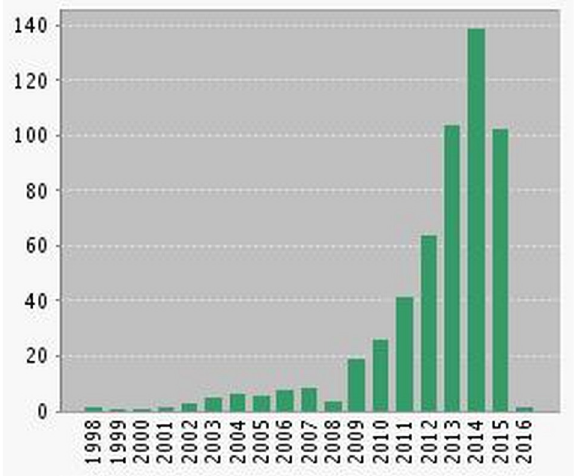
Figure 1: The number of publications on the topic of magnetic molecularly imprinted polymers published in a given year [8].